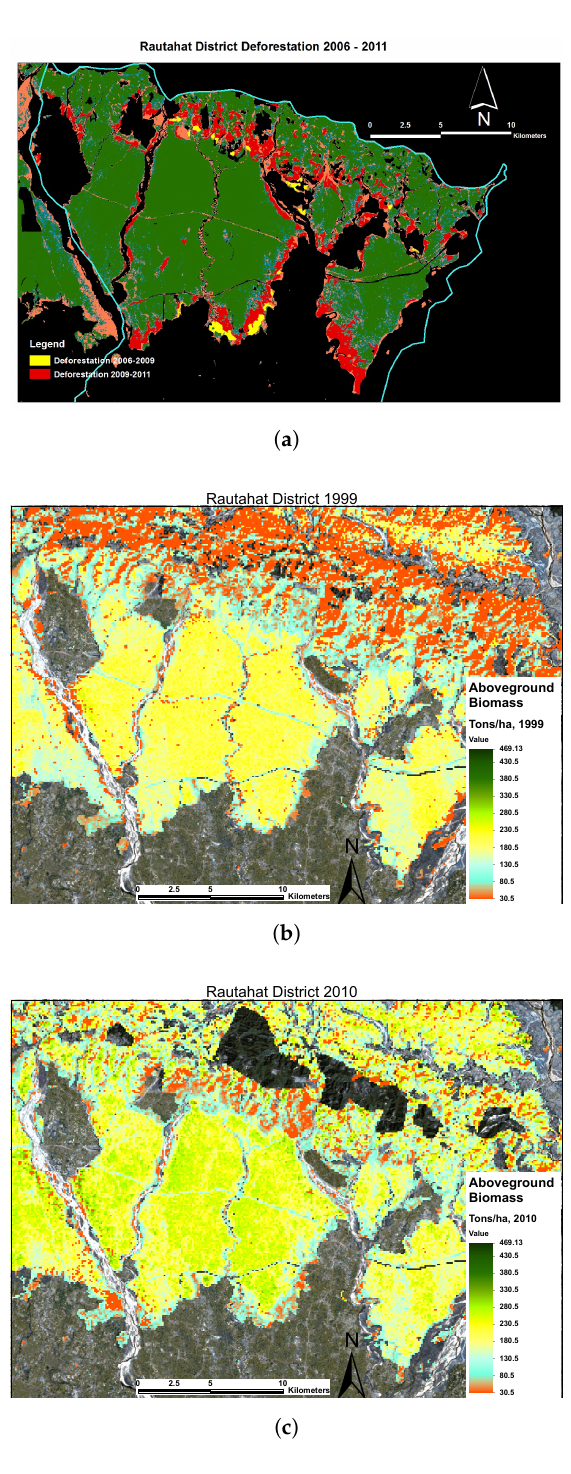
Figure 6. The three Figure 6a–c depict the estimated forest degradation and deforestation in the Rautahat district in TAL. ( a ) is the analysis of deforestation and forest degradation between the years 1999 and 2010 with LAMP2 Activity Data; ( b ) is the LAMP3 estimated AGB in that same area in 1999 and ( c ) is Above Ground Biomass (AGB) as estimated with LAMP3 in 2010. The areas coincide well, but in the LAMP3 process every primary estimation unit of one hectare gets an individual Emission Factor: the difference of the carbon density on that unit between the years at which it has been